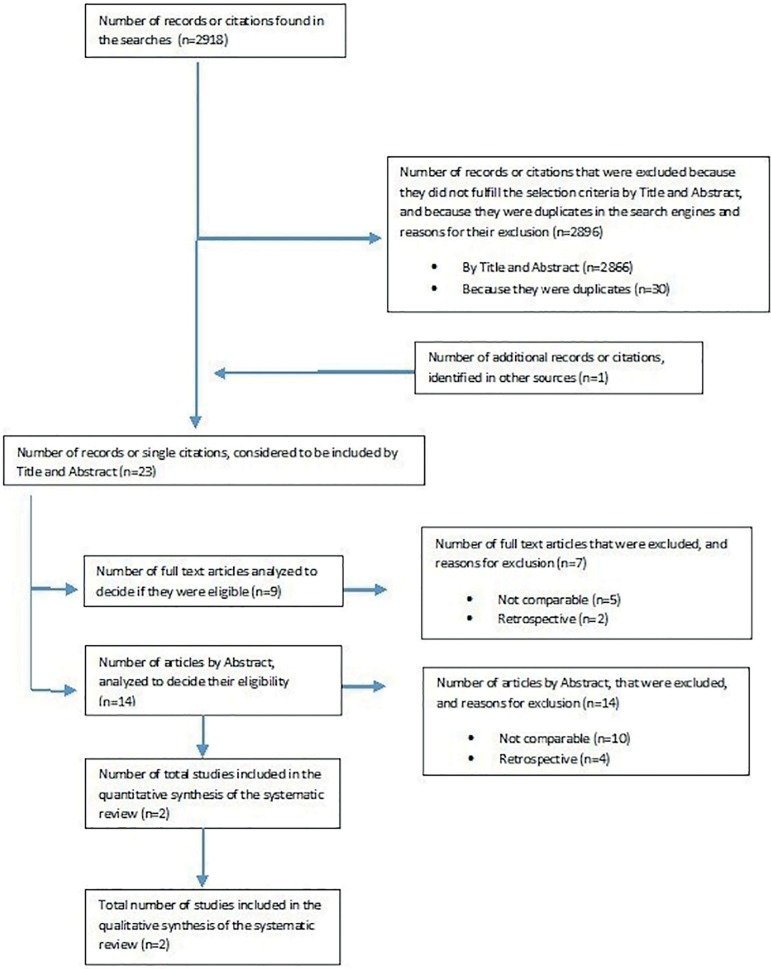
Flow diagram illustrating the selection of trials included in the
meta-analysis